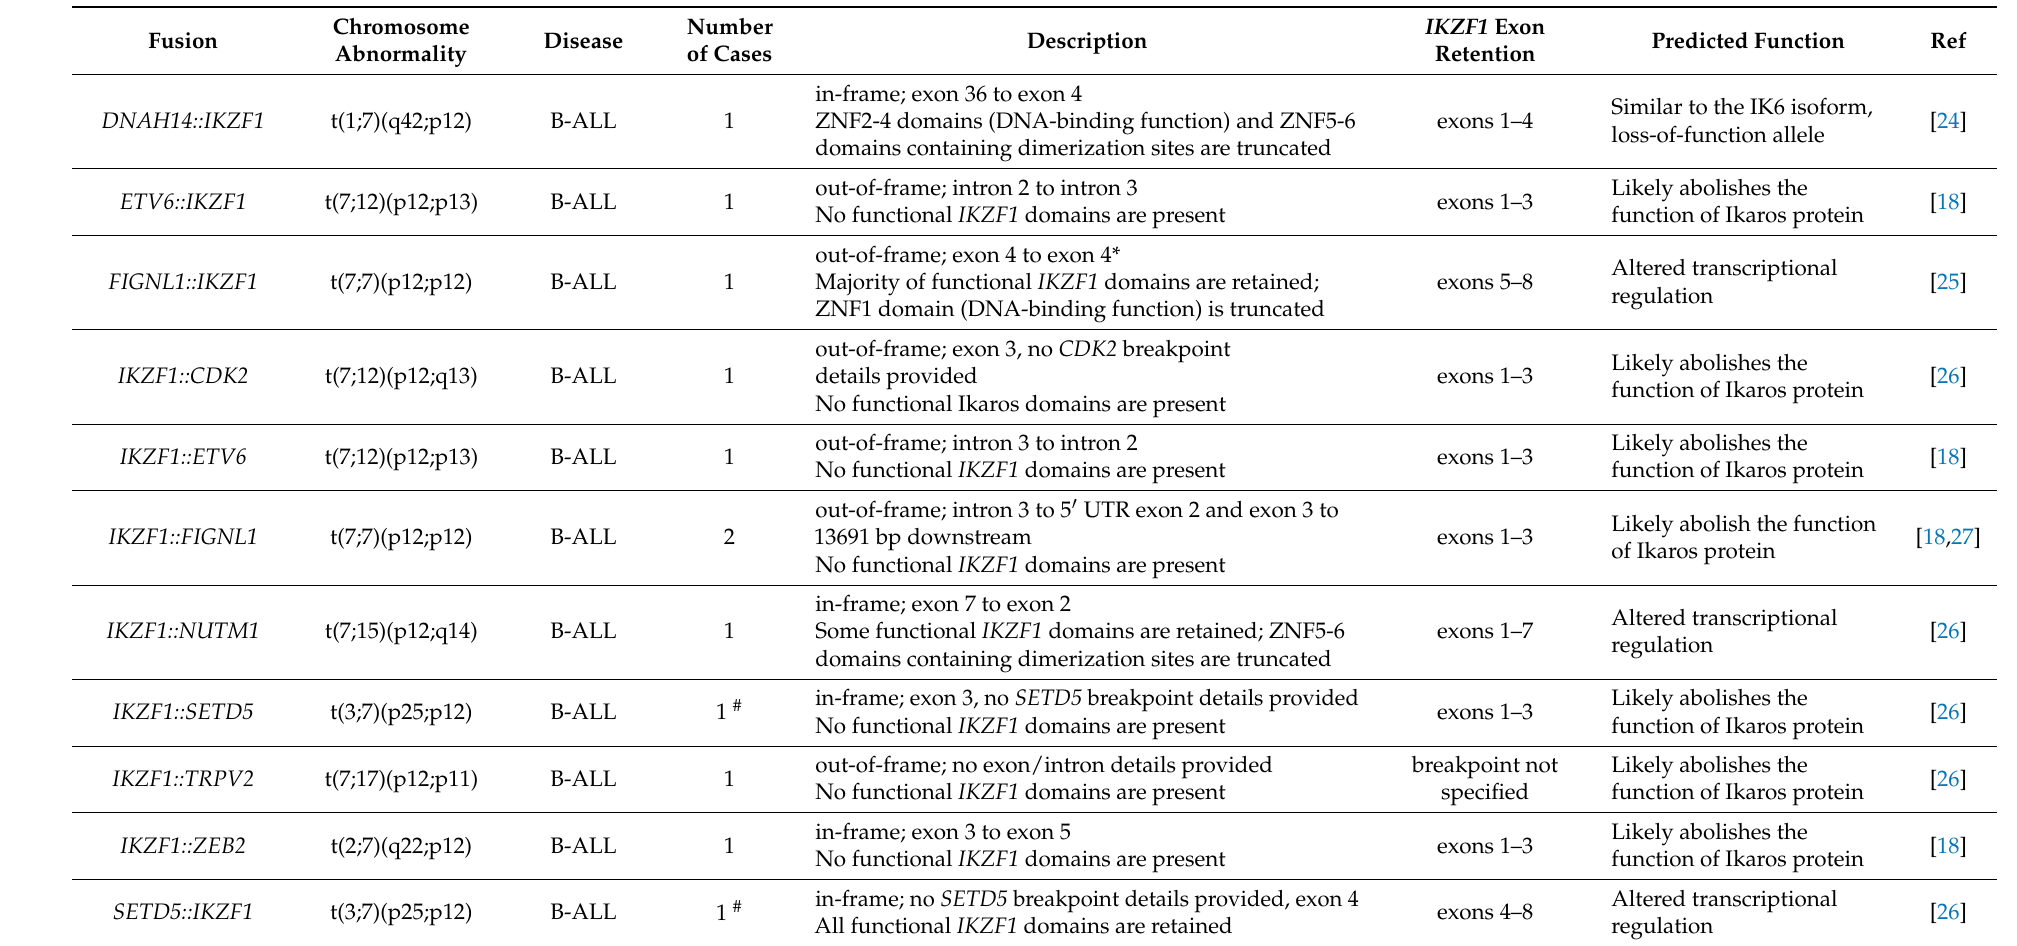
Table 1. IKZF1 gene fusions previously reported in acute lymphoblastic